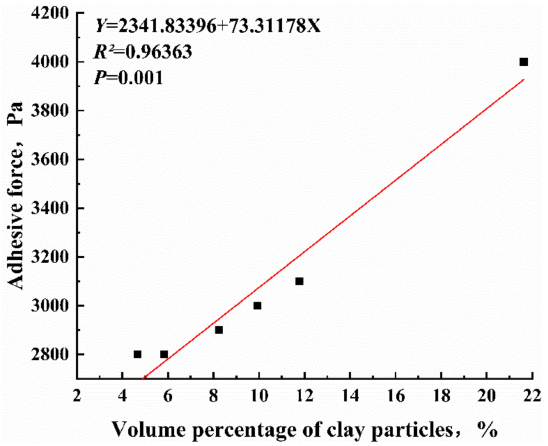
Figure 11. Correlation analysis for soil clay percentage and adhesion.